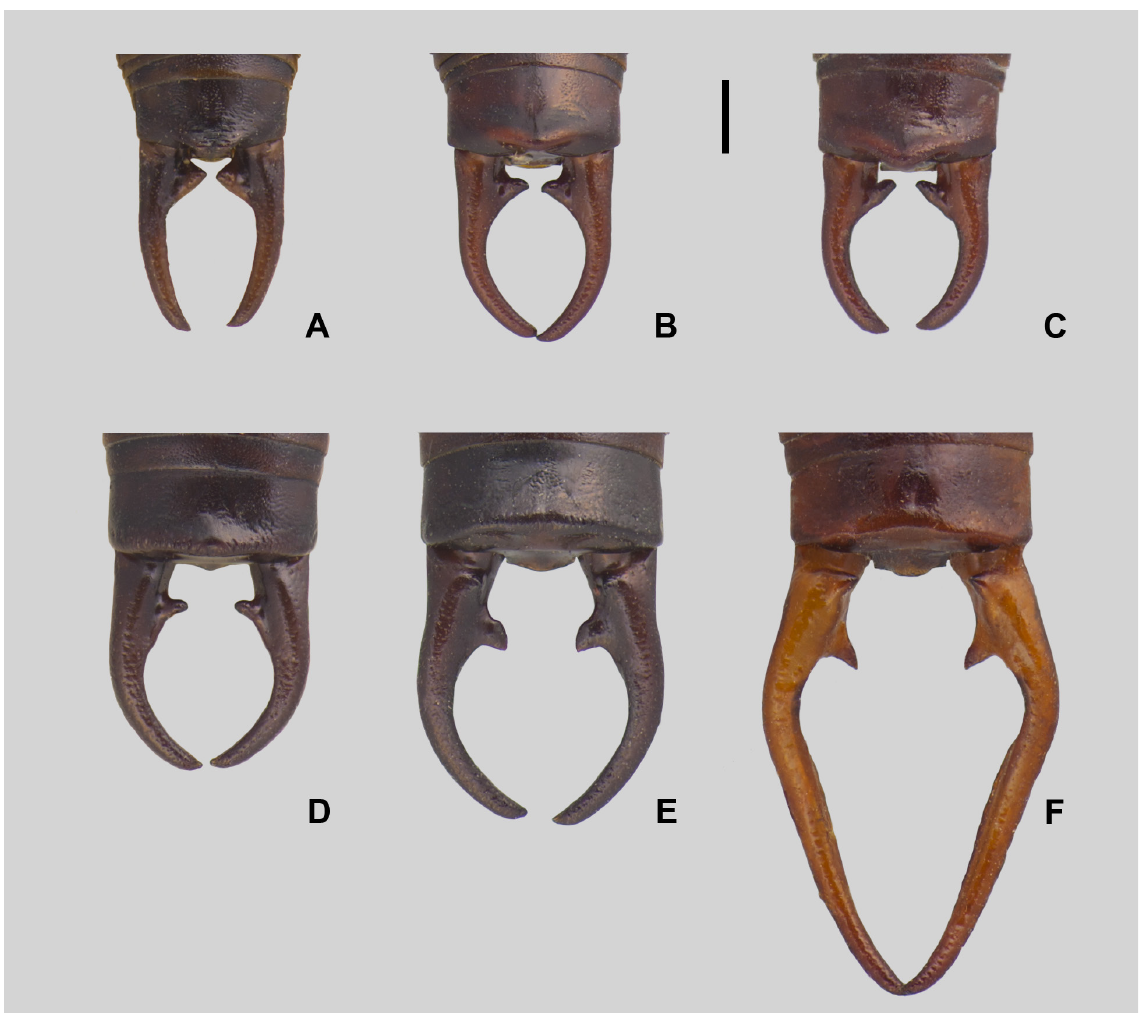
Fig. 2. Cerci variation in Pseudochelidura sinuata (Germar, 1825), males. A . Valle de Canfranc (Huesca, Spain) (MNCN_Ent 123563). B . Salardú (Lleida, Spain) (MNCN_Ent 123689). C . Puerto Pallars, Virgen de Arés (Lleida, Spain) (MNCN_Ent 123674). D . Panticosa (Huesca, Spain) (MNCN_ Ent 123568). E . Puerto de Bujaruelo (Huesca, Spain) (MNCN_Ent 123639). F . Puerto Pallars, Virgen de Arés (Lleida, Spain) (MNCN_Ent 123668). Scale bar = 1